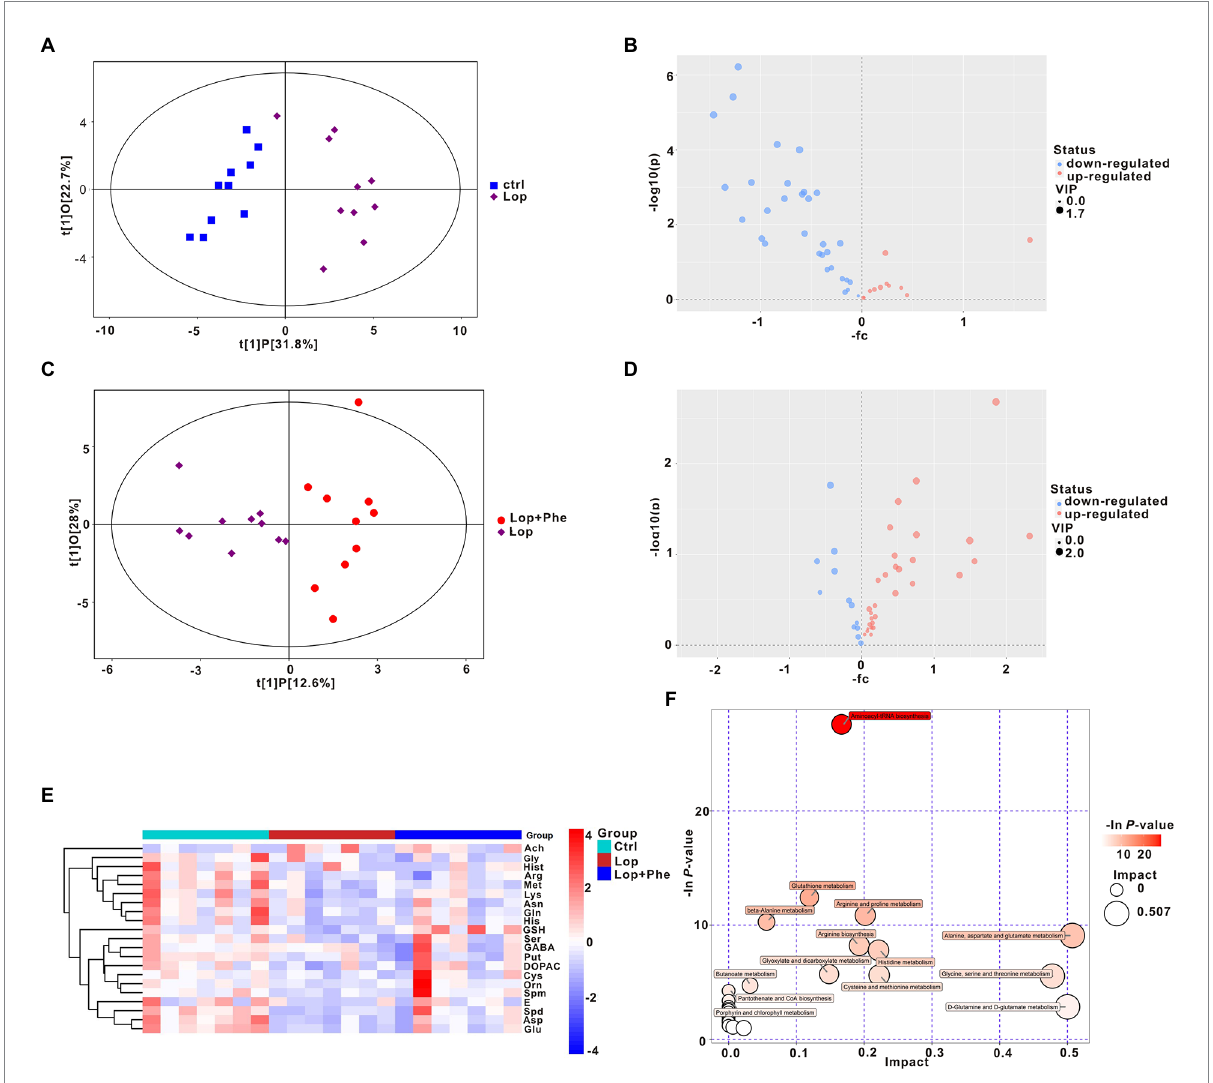
FIGURE 4 Partial reversal of metabolic disturbances by Phe in constipated rats, as revealed by targeting metabolomic data. (A,C) OPLS-DA. (B,D) Volcano plot of differential metabolites between the Ctrl and Lop groups (B) and between the Lop and Lop + Phe groups (D) . (E) Heatmap of the 21 differentially abundant metabolites between the three groups. (F) Bubble plot of metabolic pathways of differentially abundant metabolites among the three